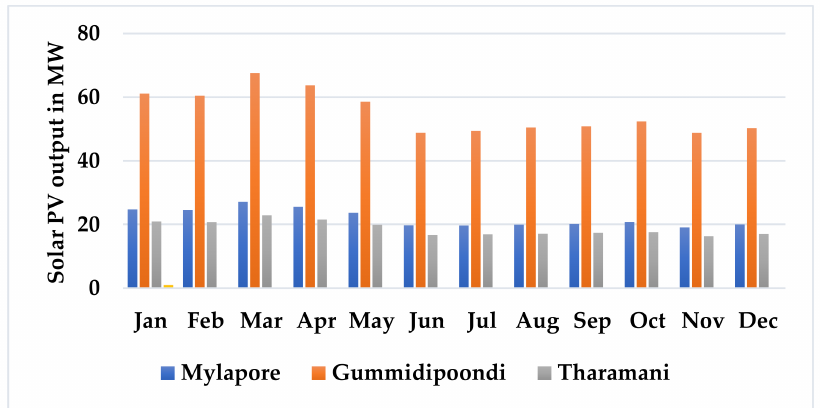
Figure 15. Monthly solar PV output at selected locations.